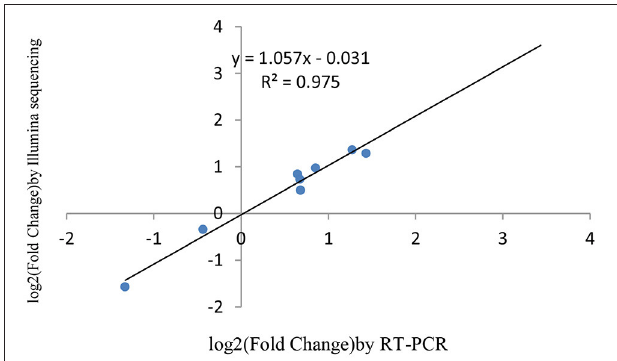
FIGURE 19 | qRT-PCR validation of differentially expressed mRNA targets.